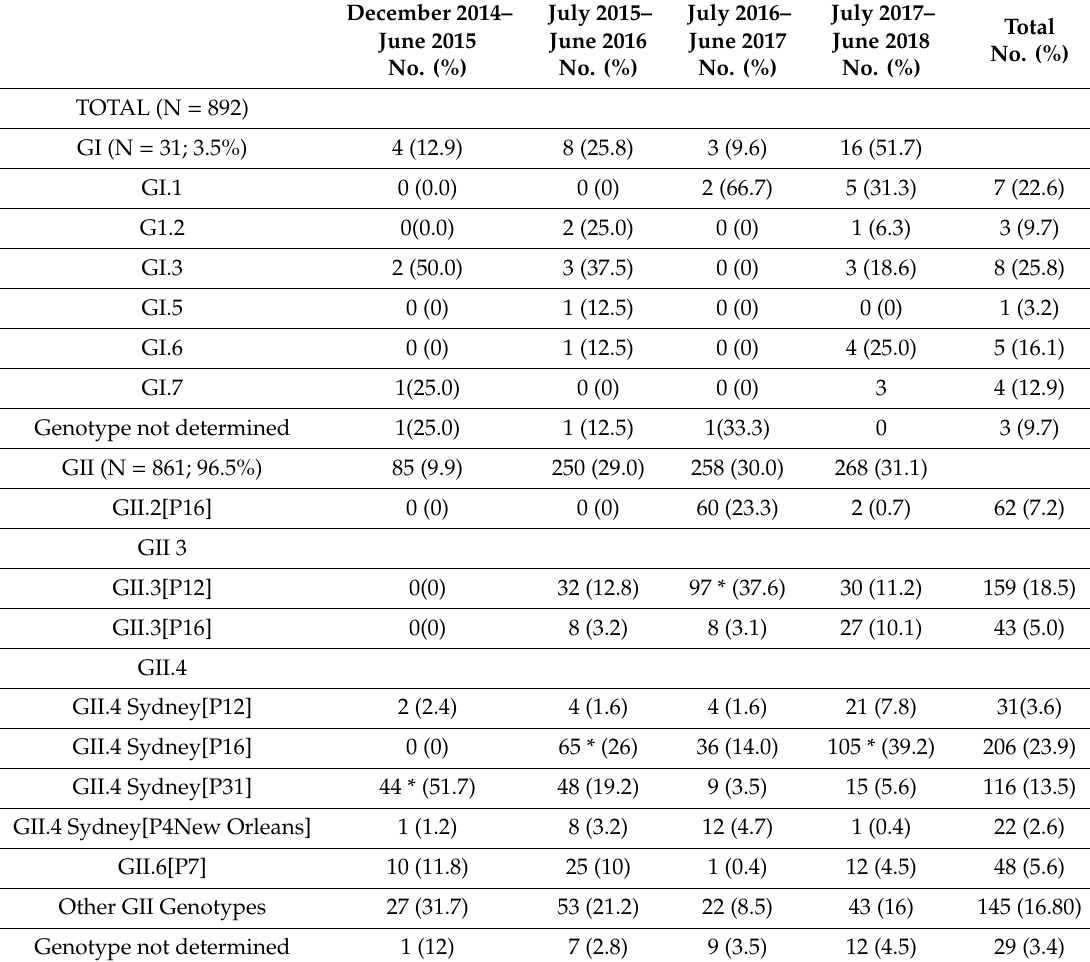
Table 3. Seasonal distribution of Norovirus Genogroups and